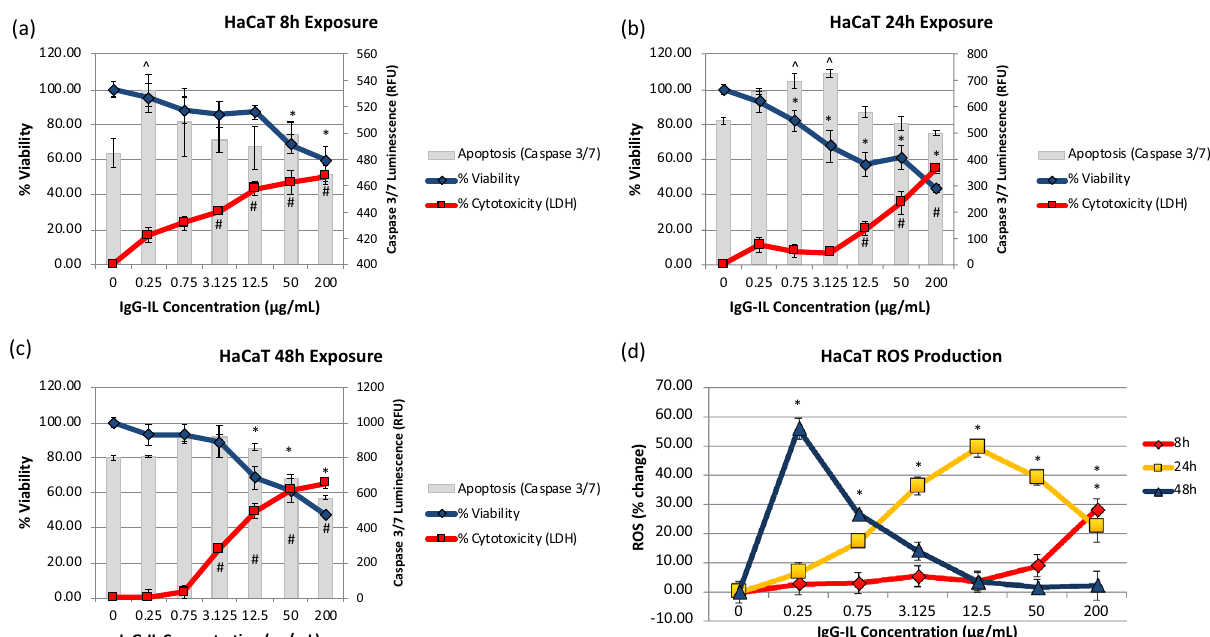
Figure 4. The viability (blue line, left y-axis), cytotoxicity (red line, left y-axis), and apoptosis (grey columns, right y-axis) results for HaCaT cells exposed to IgG-IL for 8 ( a ), 24 ( b ), or 48 ( c ) hours. Reactive oxygen species generation at 8, 24, and 48 h ( d ). Statistical significance was determined by a One-way ANOVA and a post-hoc Tukey’s Test compared to no treatment, at a confidence of 95% for n = 3, r =